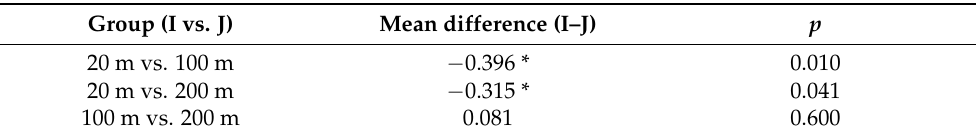
Table 13. Post hoc (LSD) multiple factors comparison analysis of impacts of different viewing distances on perceived preference.